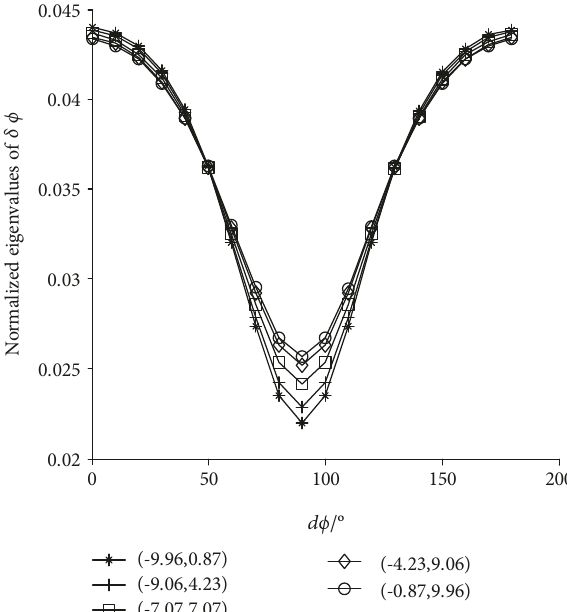
Figure 6: Normalized eigenvalues of the heading angle error δϕ under the fi ve initial positions.